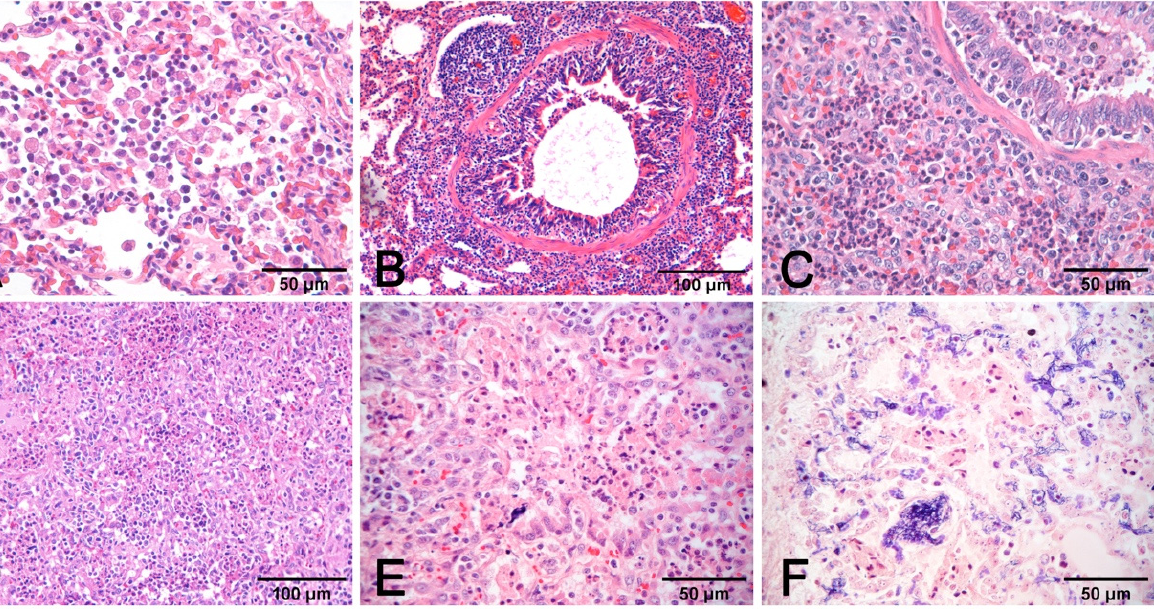
Figure 7. Pneumonia with alveolar macrophages ( A ) and lymphocytic peribronchial cuffing ( B ); when associated with gross changes in cranioventral non-complicated pneumonia, these histological findings are indicative of EP. Increase in airway and alveolar neutrophils ( C ) indicates complication. Necrosis of lung parenchyma ( D ) and of alveolar cell exudate ( E ), fibrin alveolar collection ( F ) associated with vessel fibrinoid necrosis ( G ), thrombosis ( H ), and fibrinous pneumonia ( I ) are a histologic indication of porcine pleuropneumonia, for which etiologic indication is imperative, as similar gross and histologic changes are also due to bacteria different from Actinobacillus pleuropneumoniae . ( A – E , G – I ): H–E stain. ( F ): PTAH stain.